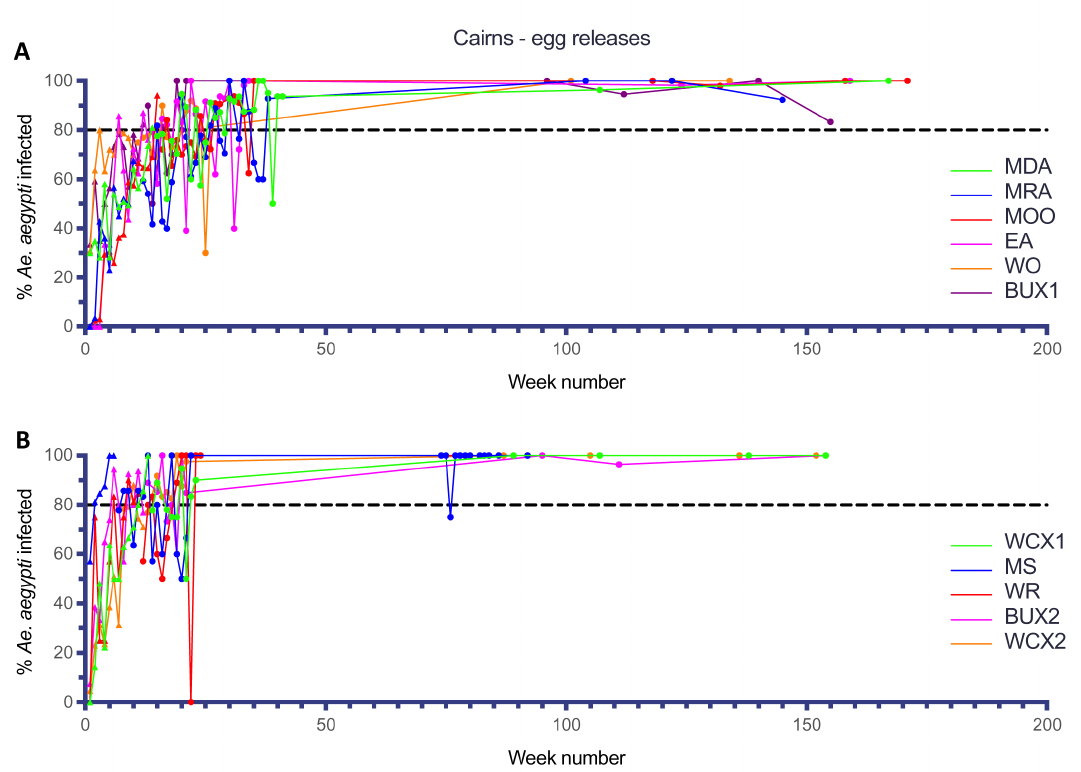
Figure 9. Wolbachia infection rates in Aedes aegypti mosquitoes collected from Manunda (MDA), Manoora (MRA), Mooroobool (MOO), Earlville (EA), Woree (WO) and Bungalow Ext 1 (BUX1) ( A ), Westcourt Ext 1 (WCX1), Mount Sheridan (MS), White Rock (WR), Bungalow Ext 2 (BUX2) and Westcourt Ext 2 (WCX2) ( B ) during release (triangles) and post-release (circles) monitoring periods ( Wolbachia infected egg releases were undertaken every 2 weeks for 9–15 weeks in MDA, MRA, MOO, EA, WO and BUX1 between May–Dec 2015, and for 6–13 weeks in WCX1, MS, WR, BUX2 and WCX2 between Sep–Dec 2015), Week number 1 corresponds to commencement of Wolbachia mosquito releases in each